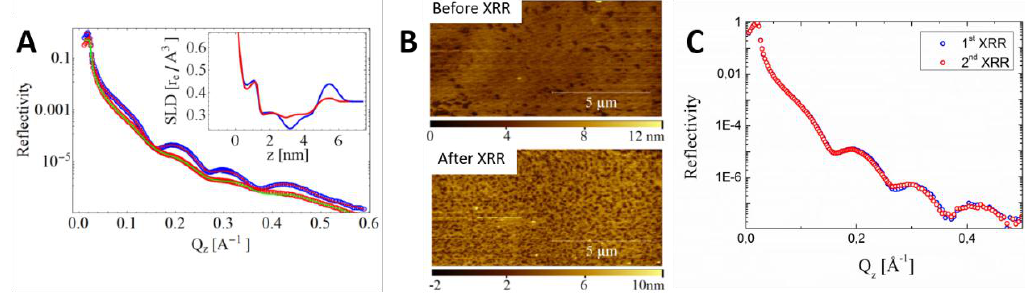
Figure 6. ( A ) XRR curves on DPPC bilayers. Blue and red : 1st XRR experimental data and best fit, respectively. Red and green (shifted for better clarity): 2nd XRR experimental data and best fit, respectively, acquired over the same sample region of the 1st XRR. Inset: SLD profiles evaluated from the fit. Blue : 1st XRR. Red : 2nd XRR; ( B ) AFM images of DPPC bilayers: ( left ) before being exposed to XR, ( right ) after being damaged by the XR beam during the acquisition of the 1st XRR (22.5 keV). Adapted with permission from [105]; ( C ) XRR curves on DPPC bilayers. Blue : 1st XRR experimental data. Red : 2nd XRR experimental data, acquired over the same sample region of the 1st XRR (30 keV); Comparing ( A ) and ( C ), it is evidenced that 30 keV produces less radiation damage to the SLBs.